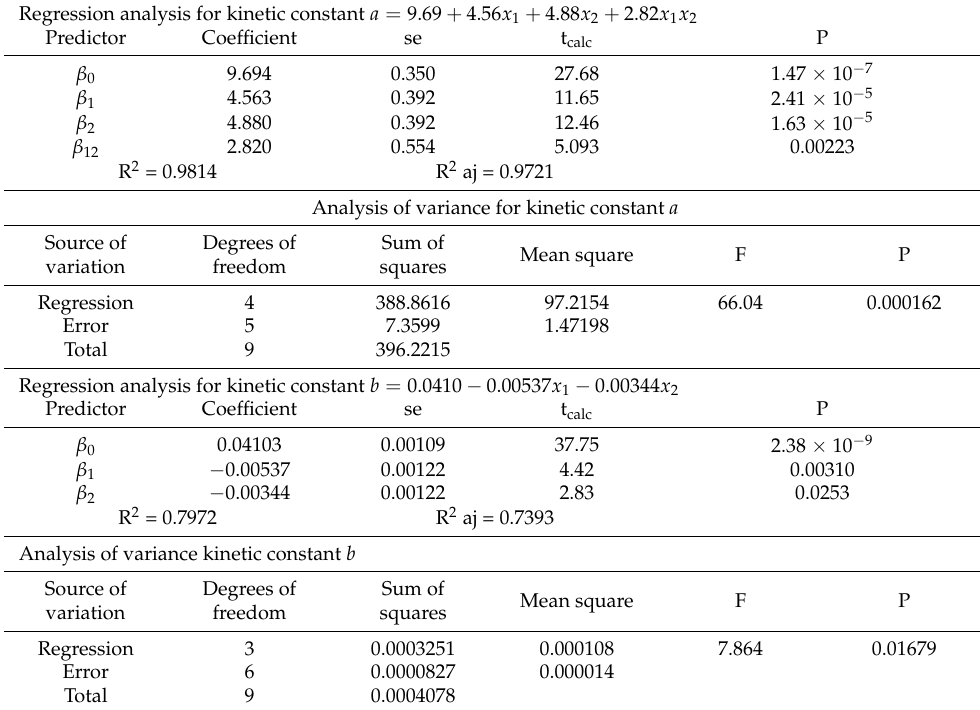
Table 3. Regression and variance analysis for RSM models for kinetic constants a and b for the enzymatic hydrolysis of milk proteins with